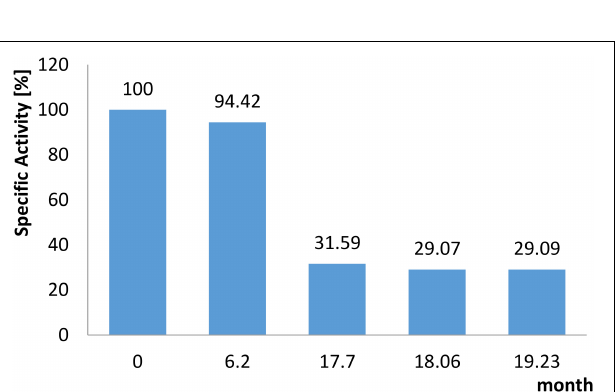
FIGURE 3 | (A) Kinetic properties of the recombinant Cc EDD. The rate dependence of the Cc EDD on 6-phoshogluconate concentration was determined in a continuous assay by coupling the KDPG formation to the NADH oxidation via S . acidocaldarius KD(P)G aldolase and L-lactate dehydrogenase from rabbit muscle. The activity was determined as absorbance decrease at 340 nm at 37 ◦ C. (B) Effect of pH on the activity of the Cc EDD, 100% activity correspond to a specific activity of 61.6 U mg - 1 .